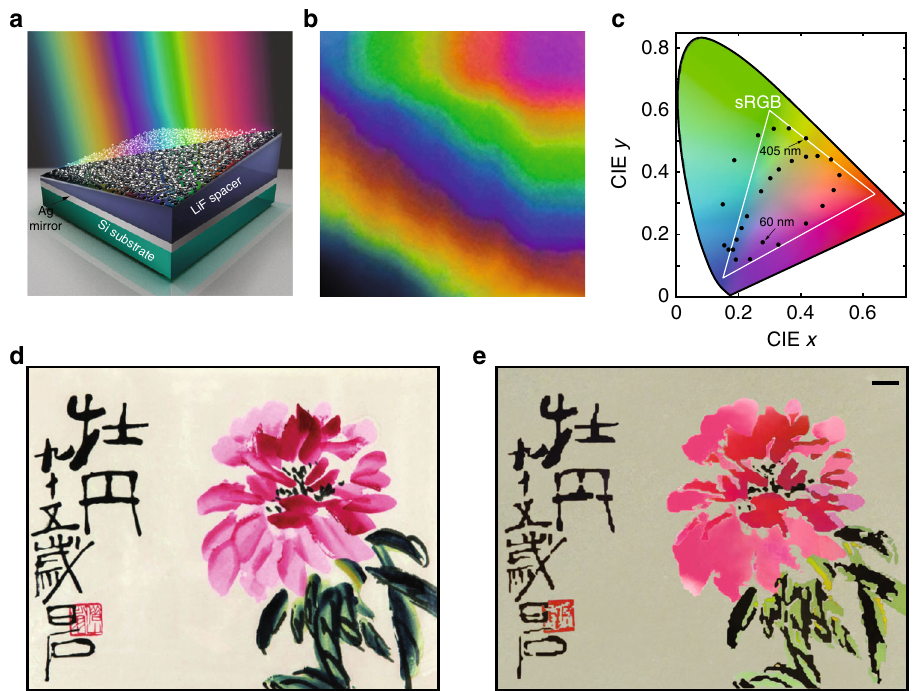
Fig. 4 The versatility of the disordered plasmonic system for colouration. a Schematic of the sample with Ag nanoclusters on a spacer with gradually varying thickness along the diagonal. b Photographic image of the structure depicted in a , with rainbow-like colours starting from black along the diagonal where coupling strength is tuned. c The diverse colour generation in CIE 1931 xy chromaticity diagram with black dots calculated from the spectra from Fig. 3c and the sRGB gamut outlined in white lines. d Digital copy of the painting (Peony Flower). e The fabricated hybrid structure. The scale bar represents 10